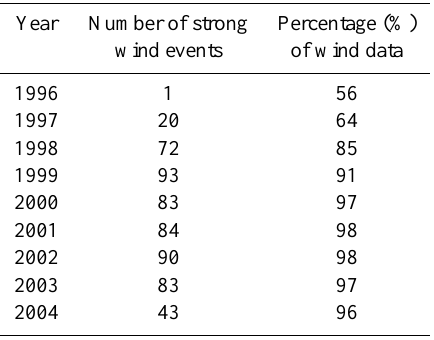
Table 1. Annual distribution of the strong wind events and percent- age of AWS wind data.